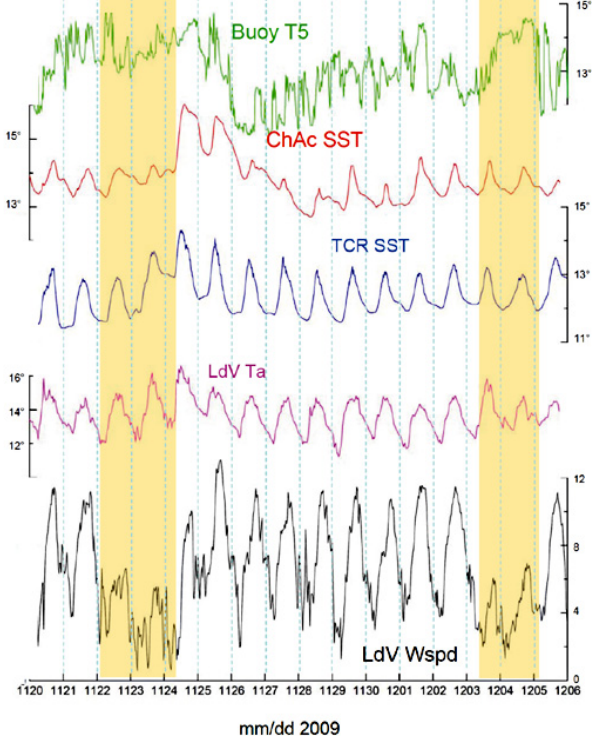
Fig. 8. Times series of selected coastal variables during CUpEx (30-min averages). From bottom to top the variable are: 3.8-m wind speed (black line) and 2-m air temperature (magenta line) at point Lengua de Vaca, shore SST at Talcaruca (TCR, blue line) and Cha˜naral de Aceituno (ChAc, red line), and 5-m deep sea tempera- ture at the Tongoy bay buoy (green line). The yellow-shaded rect- angles indicate the low-wind periods during